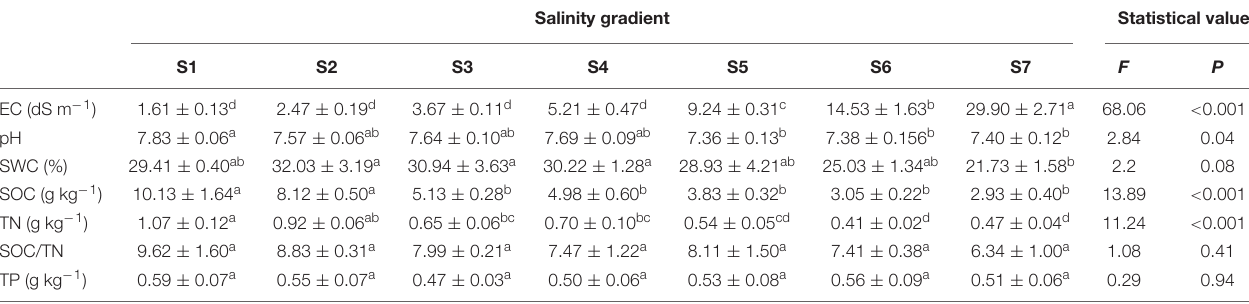
FIGURE 1 | Sampling site of coastal wetlands in the Yellow River delta and photos of Phragmites australis along a soil salinity gradient. TABLE 1 | Soil physicochemical properties with 7 salinity concentrations under coastal wetlands in the Yellow River delta. Salinity gradient Statistical